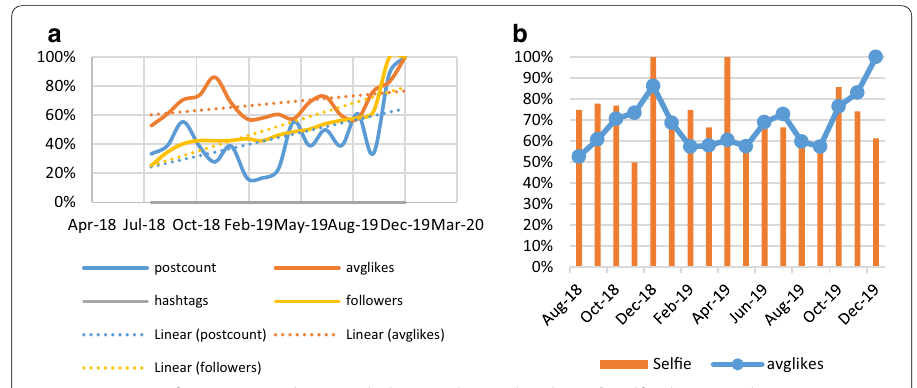
Fig. 12 a Posting frequency in relation with the popularity related KPIs. b Selfie sharing with average number of likes over